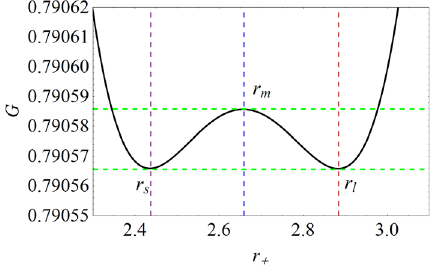
Fig. 5 Gibbs free energy as the function of r + with the non-linear charge correction ¯ φ = 10 − 5 and the parameters k = 1 , q = 1